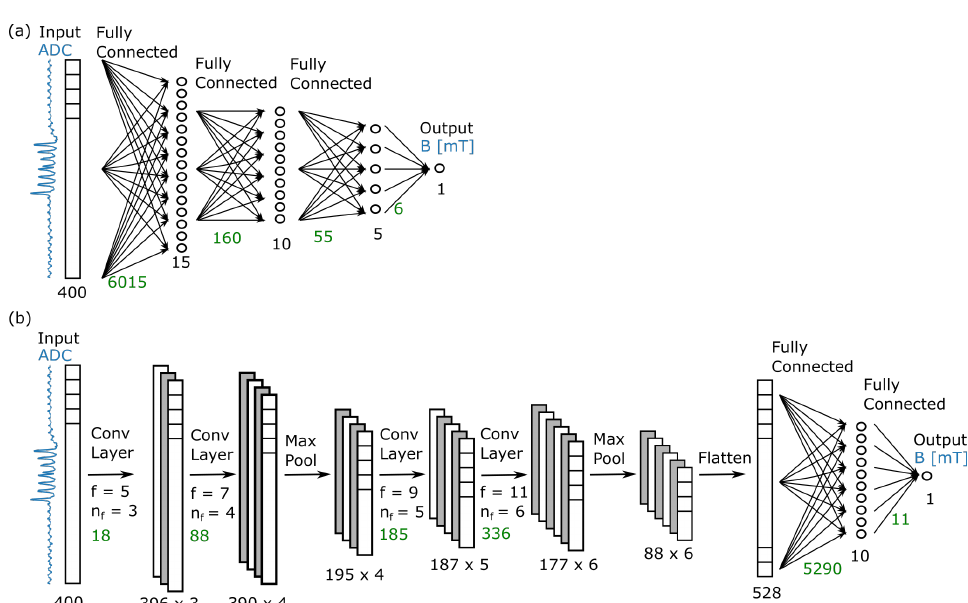
Figure 5. Employed neural network architectures of the fully connected neural network in ( a ) and the convolutional neural network in ( b ). The fully connected network has three hidden layers that decrease in size with the depth of the network. The convolutional neural network consists of a sequence of convolutional layers and max pooling layers, followed by two fully connected layers. The dimension of each layer is given in black; the number of trainable parameters per layer is given in green. For the CNN, f denotes the number of filters and n f denotes the kernel size applied in the respective convolution layer. The pool size of the max pool layers is